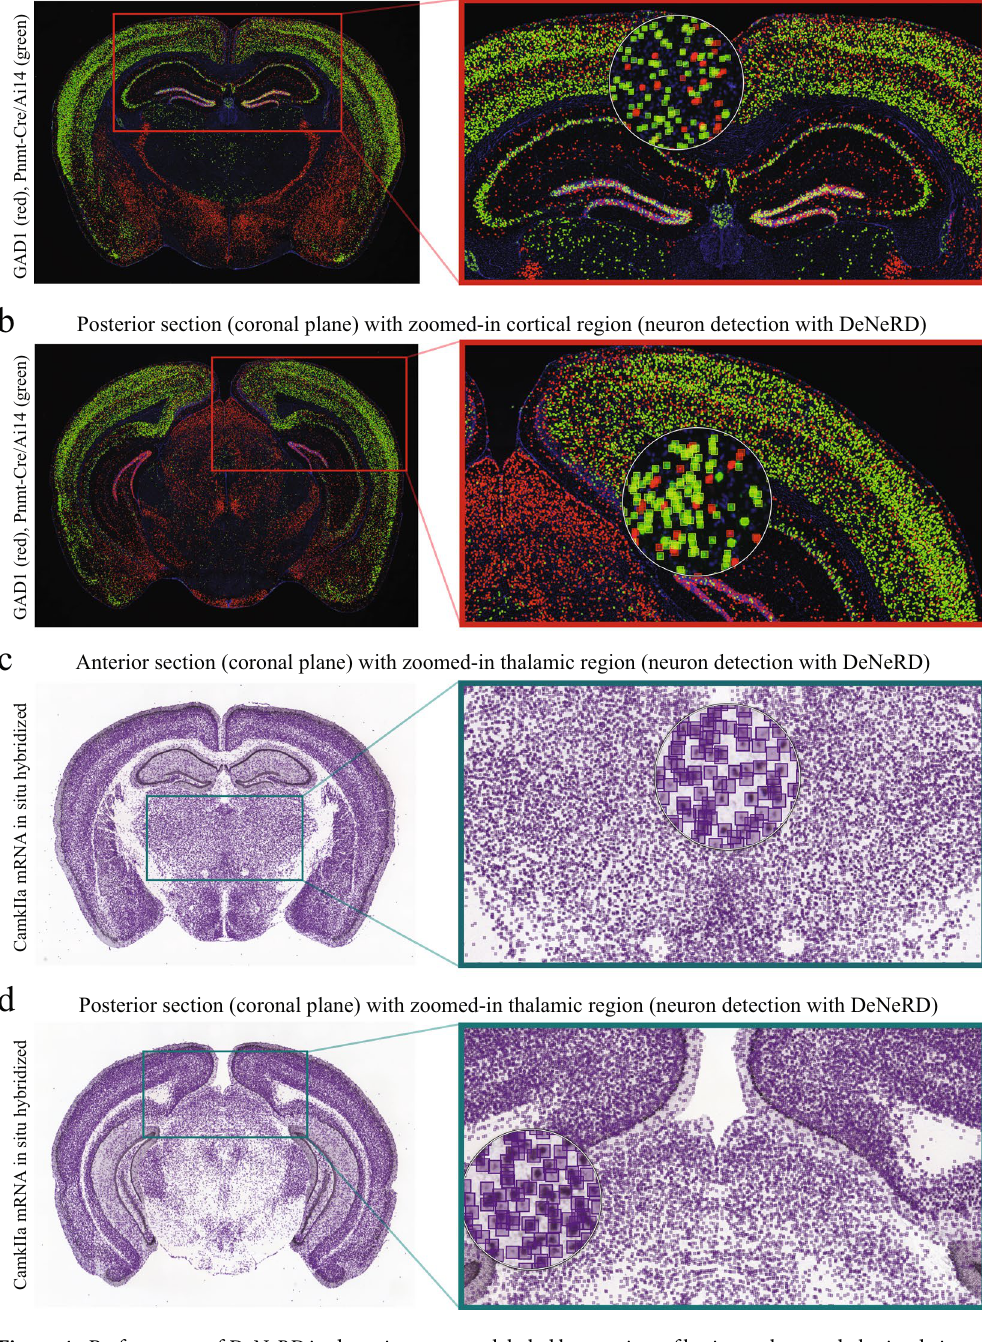
Figure 4. Performance of DeNeRD in detecting neurons labeled by a variety of brain markers and obtained via different imaging modalities at a coronal plane. ( a ) The performance of DeNeRD is shown in detecting neurons in a coronal section from the anterior part of a postnatal (P) 57 mouse’s brain which are fluorescently labeled for GAD1 tdTomato (red) and Pnmt-Cre/Ai14 (green). The detections of the deep neural network can be visualized as red (tdTomato) and green (Pnmt-Cre/Ai14) bounding boxes on top of neurons. The red box is the area shown as zoomed-in on the right side. ( b ) The performance of the method in detecting neurons in a posterior section from the mouse brain fluorescently labeled for GAD1 tdTomato (red) and Pnmt-Cre/Ai14 (green) is shown. Zoomed-in image from the CA1/subiculum hippocampal region is shown with neuron detection on the right side. ( c ) An anterior section from an adult brain labeled for CamkIIa by mRNA in situ hybridization is shown with neuron detection. Performance of the deep neural network in detecting excitatory neurons in the thalamus (purple bounding boxes) is shown on the right side. ( d ) A posterior section from the CamkIIa brain is shown with neuron detection. Performance of the deep neural network-based method in detecting neurons in the brainstem is showcased on the right side (zoomed). The original brain sections are obtained from 3 . Image credit: Allen